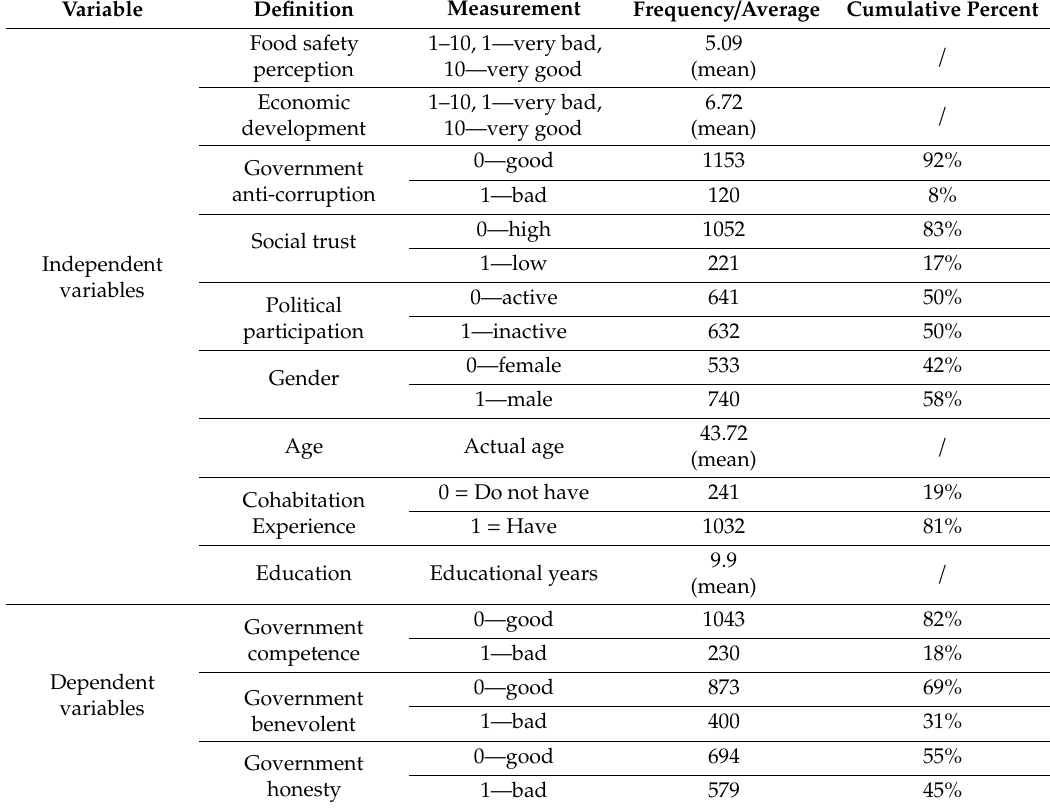
Table 1. Variable definition and descriptive